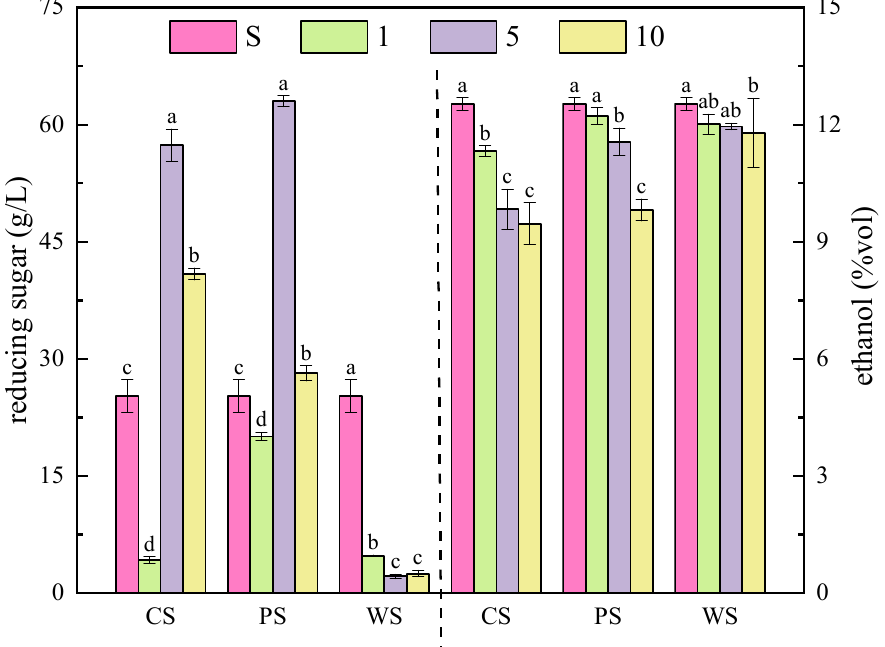
Figure 4. The contents of ethanol and reducing sugar of different ester-producing yeasts with S. cerevisiae NCUF309.2 at different ratios on 7 d of simulated fermentation of blueberry wine. (The content of reducing sugar is on the left, and the content of ethanol is on the right. Different letters represent significantly different ( p < 0.05)).